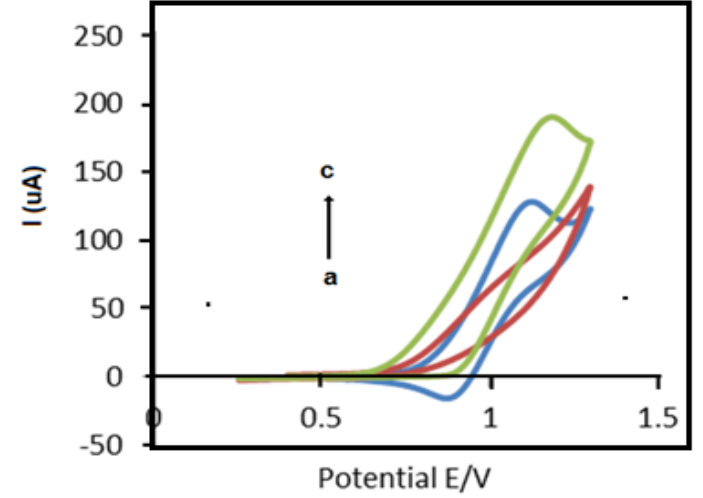
Figure 3. [Ru(bpy) 3 ] 2 + current peak of the DNA biosensor by CV: (a) SPCE / MPA-Fe 3 O 4 / NCC / EDC / NHS, (b) SPCE / MPA-Fe 3 O 4 / NCC / CTAB / EDC / NHS / DNA, (c) SPCE / MPA-Fe 3 O 4 / NCC / CTAB / EDC / NHS / DNA-DNA target.